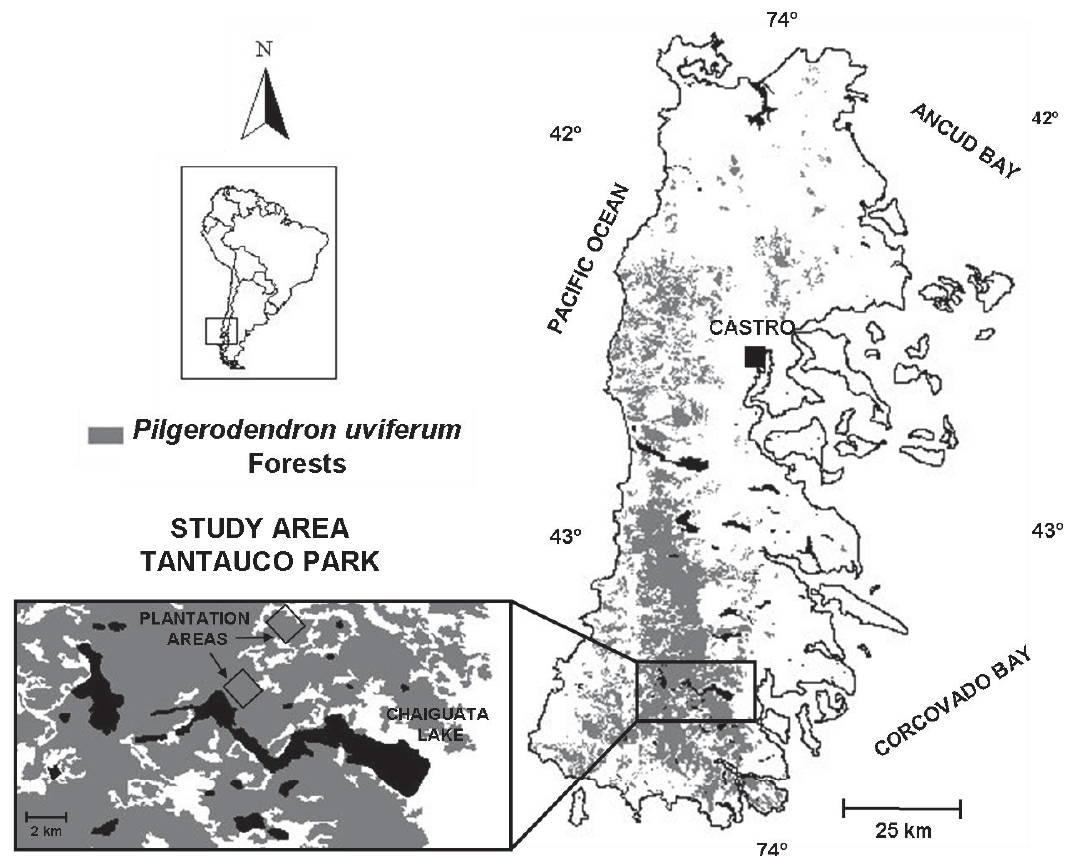
Figure 1. Study area in Tantauco Park on Chiloé Island, North Patagonia. Gray color corresponds to Pilgerodendron uviferum dominated forests. Dark patches correspond to